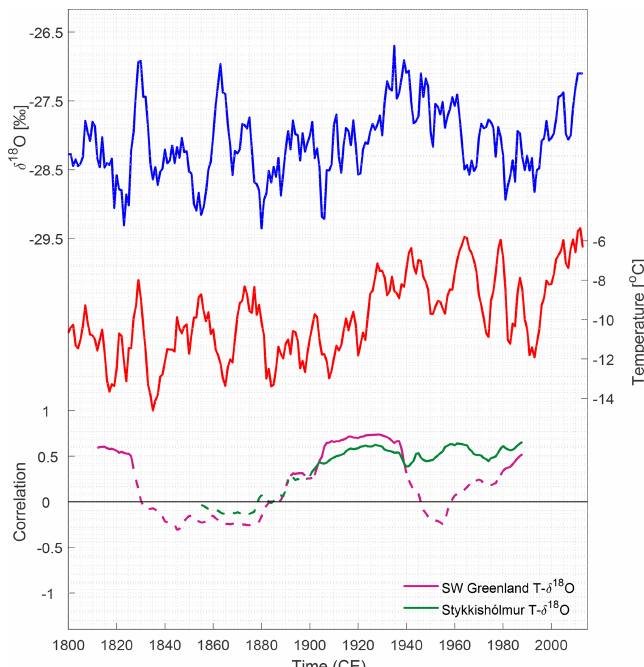
Figure C4. (a) Five-year moving average of the winter-averaged δ 18 O stack. (b) Five-year moving average of the December– January–February averaged southwest Greenland temperatures from Vinther et al. (2006). (c) 50-year running correlations between δ 18 O and southwest Greenland (magenta) and δ 18 O and Stykkishól- mur (green). Each year represents the midpoint of the running win- dow. Solid lines are significant correlations and dashed lines are insignificant ( p > 0 . 05).